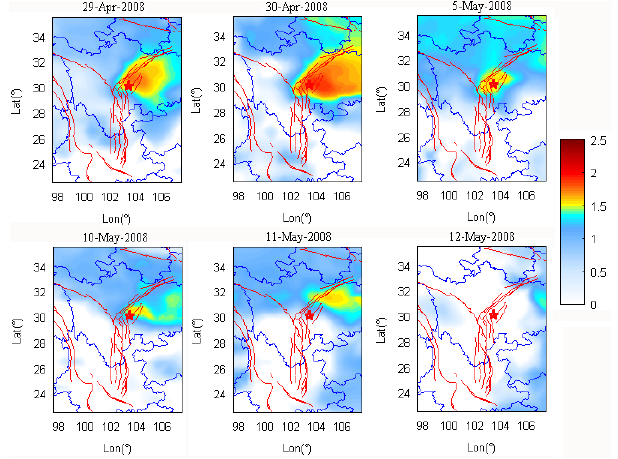
Fig. 4. The daily OLR anomaly evolution before the Wenchuan M s = 8.0 earthquake on 12 May 2008 (epicenter is marked with red star, active faults with red lines).